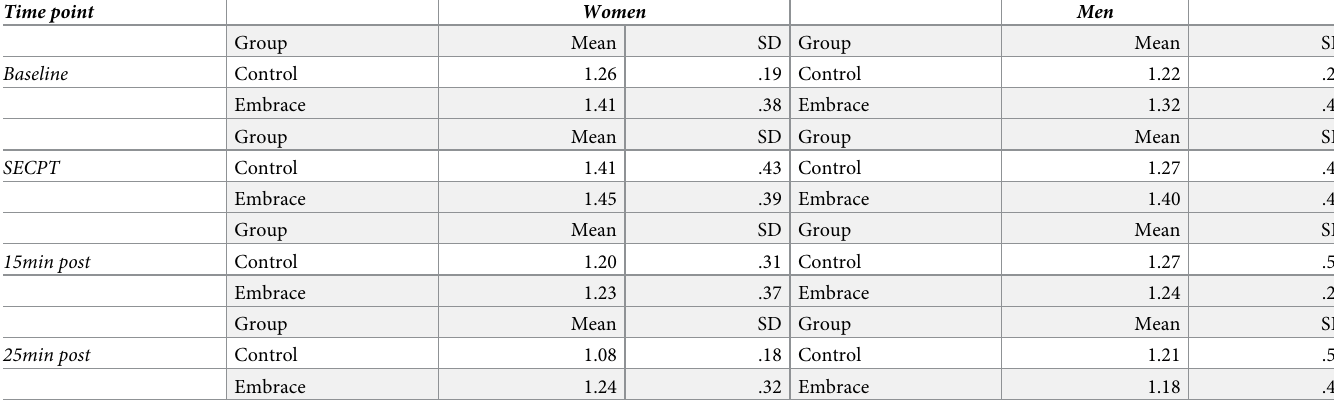
Table 5. Descriptive values (mean value and standard deviation) of negative PANAS values across the four measurement time points broken down by condition and sex.